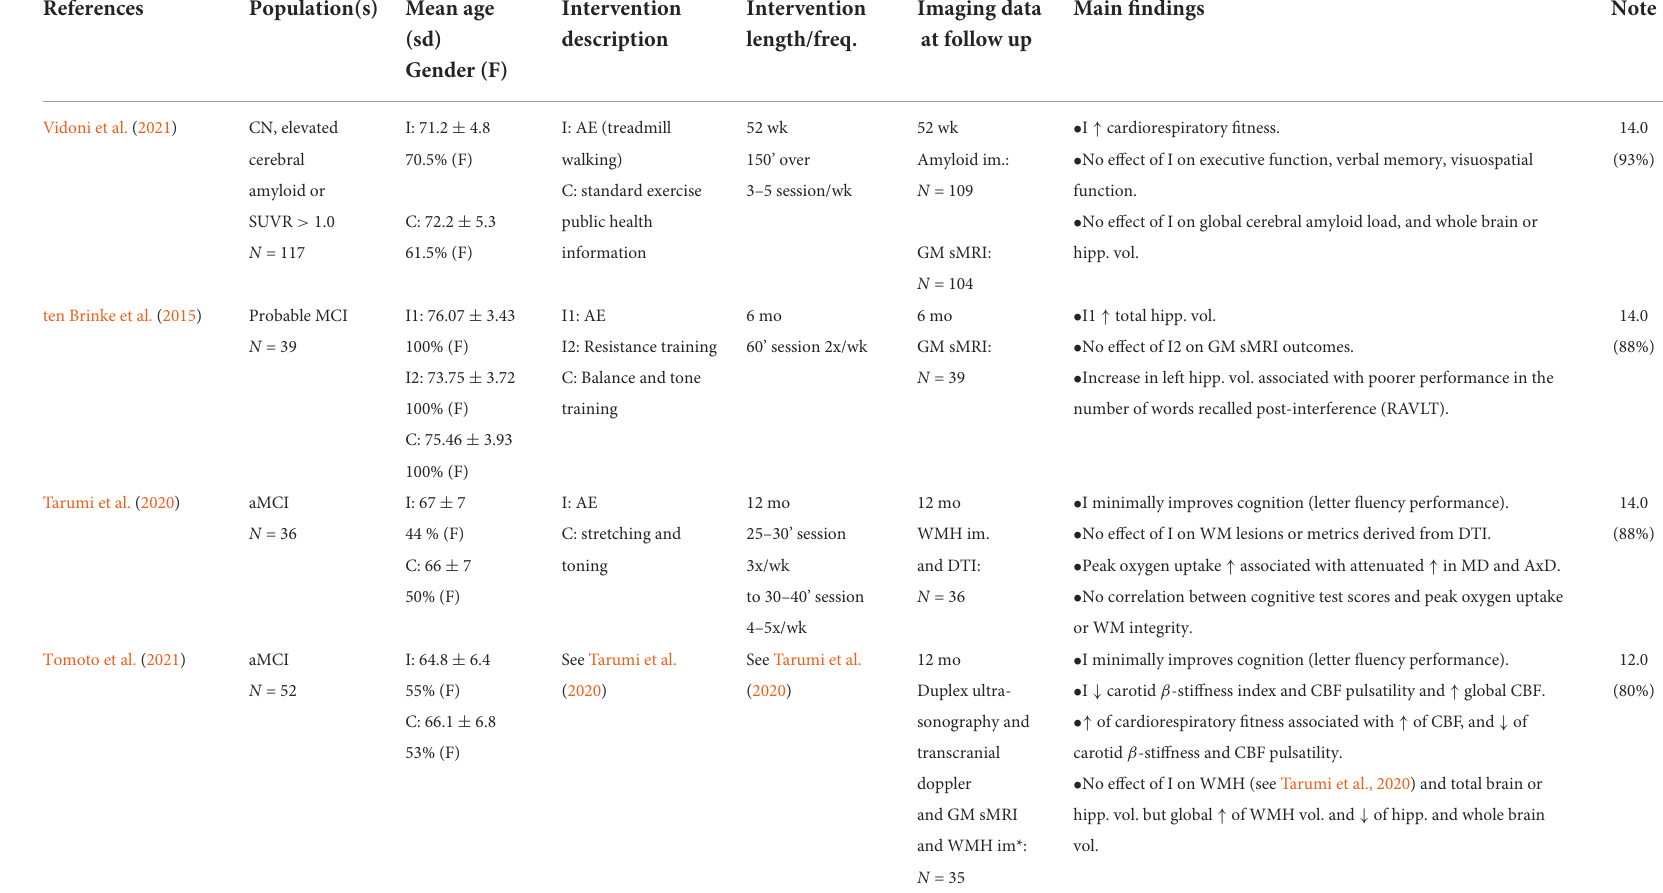
TABLE 4 Physical exercise (PE)